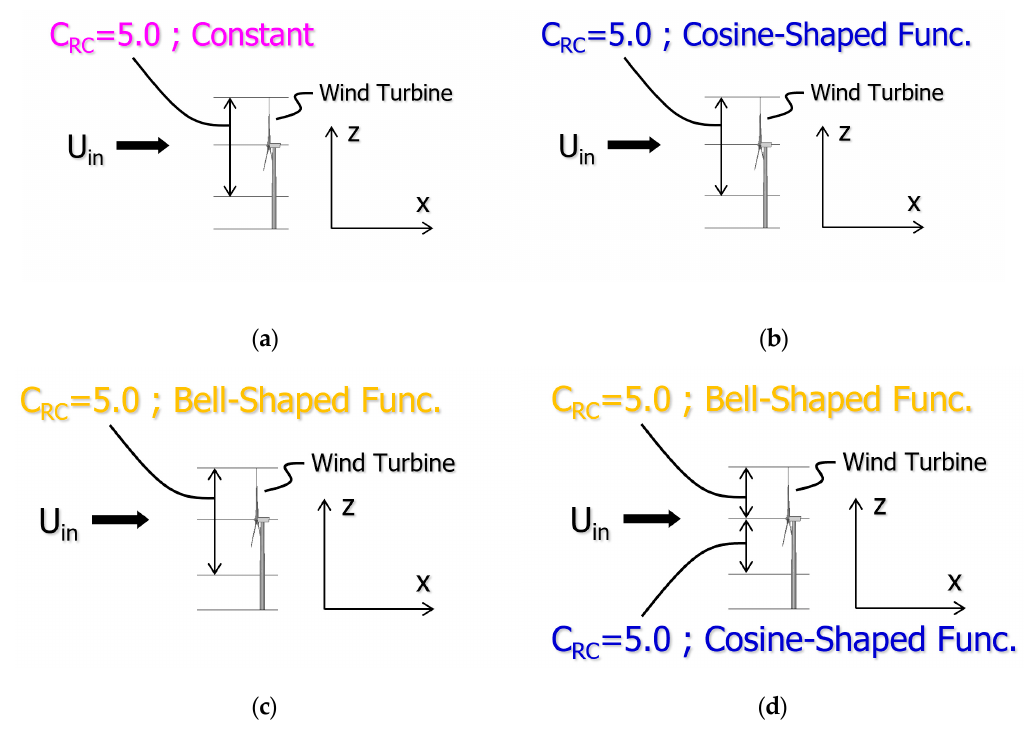
Figure A1. Four types of function shapes examined in this study. ( a ) constant; ( b ) cosine-shaped function; ( c ) bell-shaped function; ( d ) cosine-shaped + bell-shaped function.